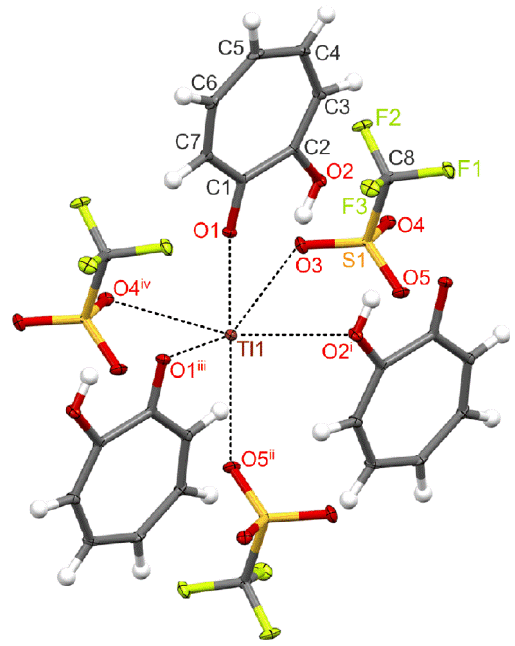
Figure 2. A fragment of the crystal structure of Tl(OTf)·Htrop adduct showing the near surroundings around the thallium(I) ion (nonhydrogen atoms shown as 50% ellipsoids).